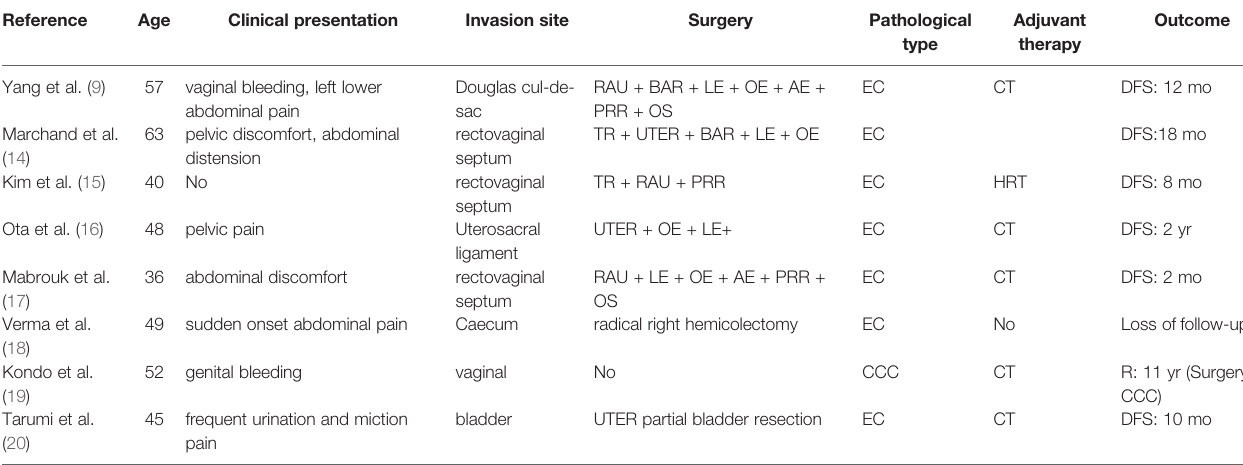
TABLE 1 | Summary of cases of DIE malignant transformation.